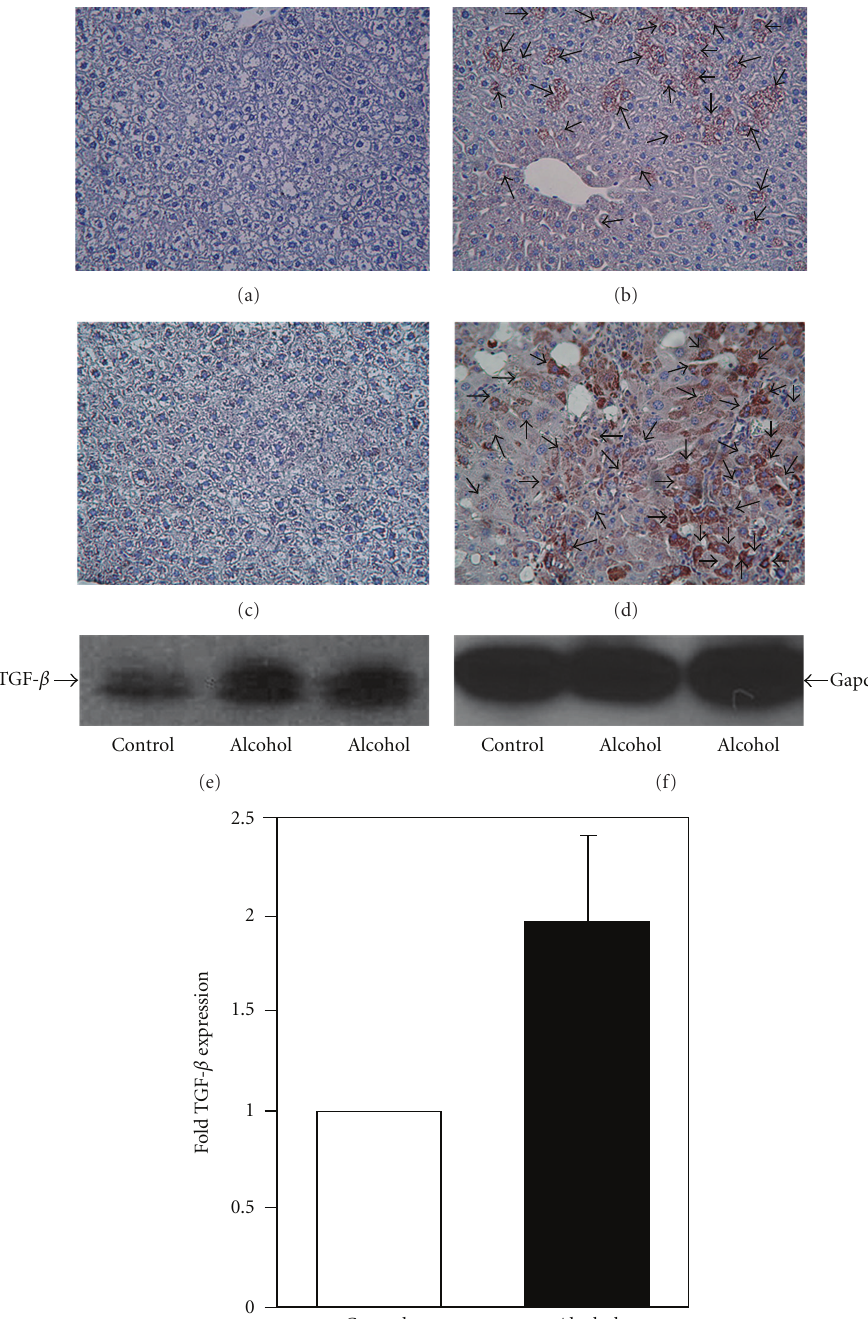
Figure 2: TGF- β Expression . The fixed liver sections of mice fed with regular (a) or ethanol-containing (b) Lieber-De Carli liquid diets were immunostained with an anti-TGF- β antibody, as described in Materials and Methods. Liver sections from mice injected (i.p.) with sunflower oil, as control (c) or carbon tetrachloride (d) for 8 weeks were also immunostained with the anti-TGF- β antibody to serve as positive controls for TGF- β staining. The arrows indicate TGF- β expression (b, d) (original magnification 20X). Whole cell lysates isolated from the livers of mice fed with regular (control) or ethanol-containing (alcohol) Lieber-De Carli liquid diets were employed to determine TGF- β protein expression by western blotting, as described in Materials and Methods (e). An anti-gapdh antibody was employed to confirm equal protein loading (f). TGF- β protein expression, normalized to gapdh, in alcohol-treated mice was expressed as fold expression of that in control mice and was quantified by scanning autoradiographs by a densitometer